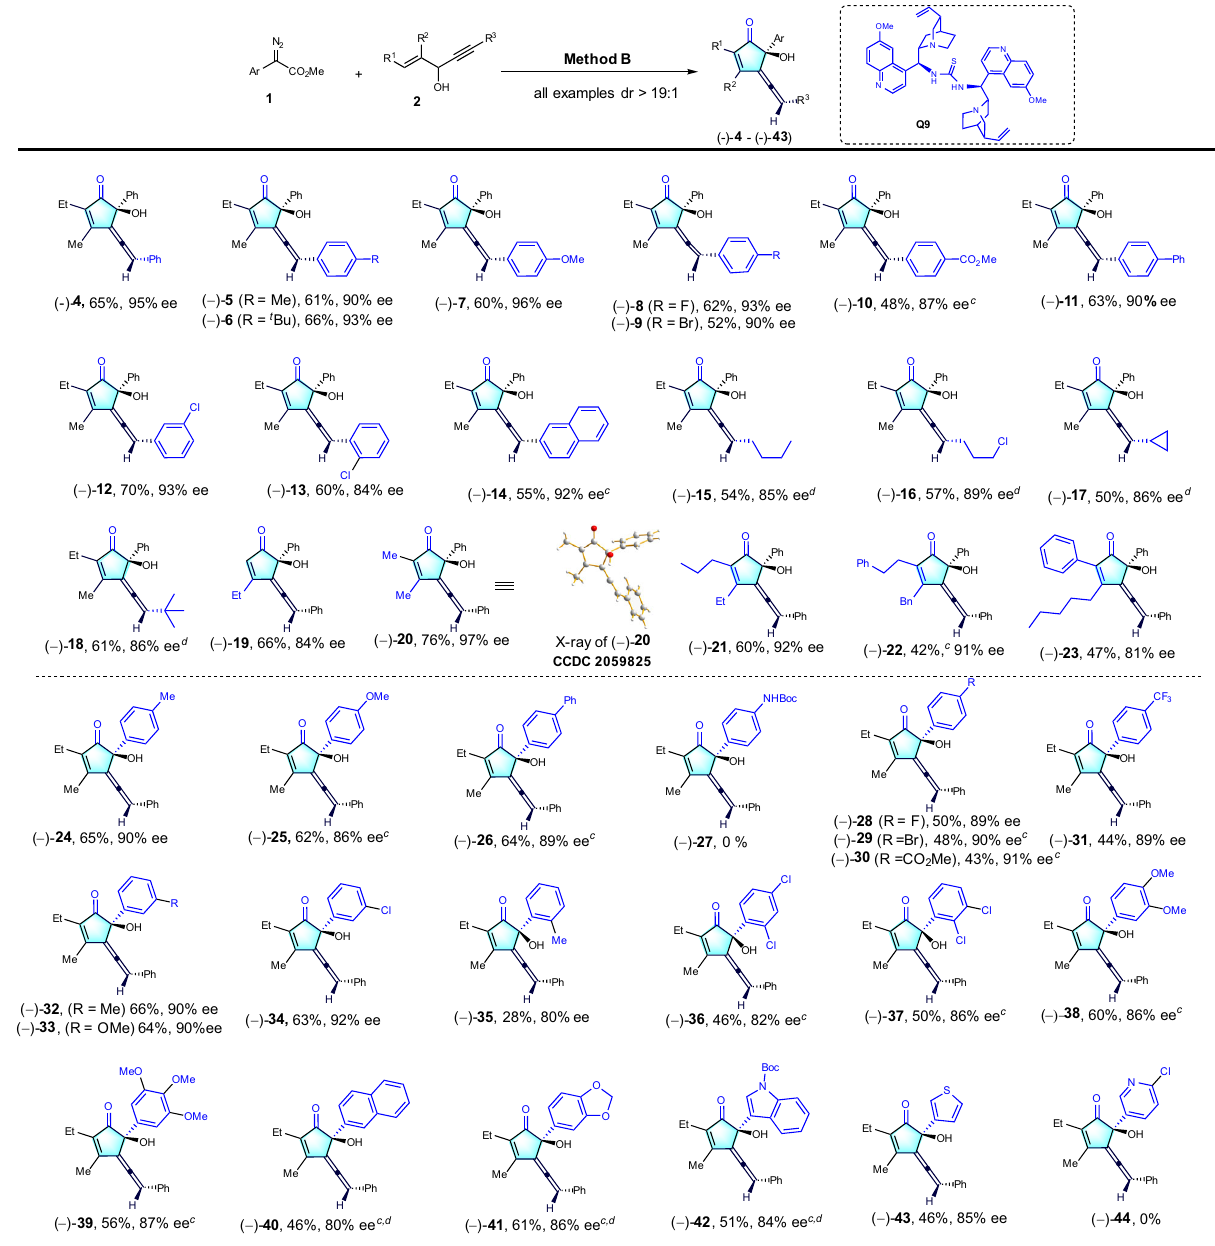
Fig. 5 Enantioselective version substrate scope. a Method B: 1 (0.3 mmol, 1.5 eq.), 2 (0.2 mmol, 1eq.), and Rh 2 (OAc) 4 (2 mol%) in hexane (2 mL) stirred at room temperature for 12 h. Then, removing the solvent and CPME (2.0 mL), Q9 (15 mol%) and 4 Å MS (40 mg) were added. The mixture was stirred for another 72 h. b Isolated yields; all examples dr >19:1; the ee values were determined by chiral HPLC analysis. c Mixed solvent (toluene/hexane = 1:3, 2 mL) instead of hexane in fi rst step. d The second step of method B for 96 h, and then the MgO (400 mg) was added and stirred for another 5